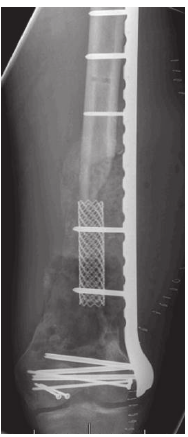
Figure 3: Composite fixation consisting of lateral locking distal femoral plate with endosteal titanium cage augment.